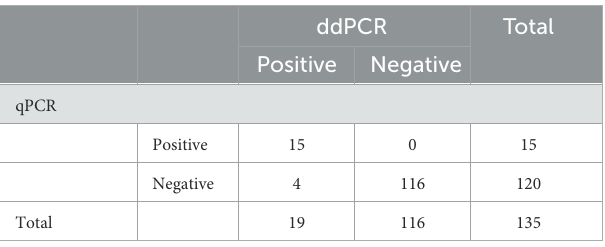
TABLE 4 Comparison of ddPCR and qPCR sensitivity for PoRVA clinical